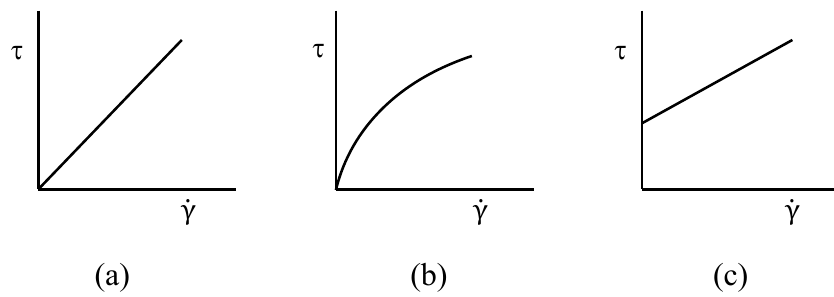
Figure 3: Typical curves of stress as a function of shear rate for viscous bodies: (a) linear viscous (Newtonian fluid); (b) non-linear viscous; (c) “plastic Bingham” (viscoplastic). Modified from [15,